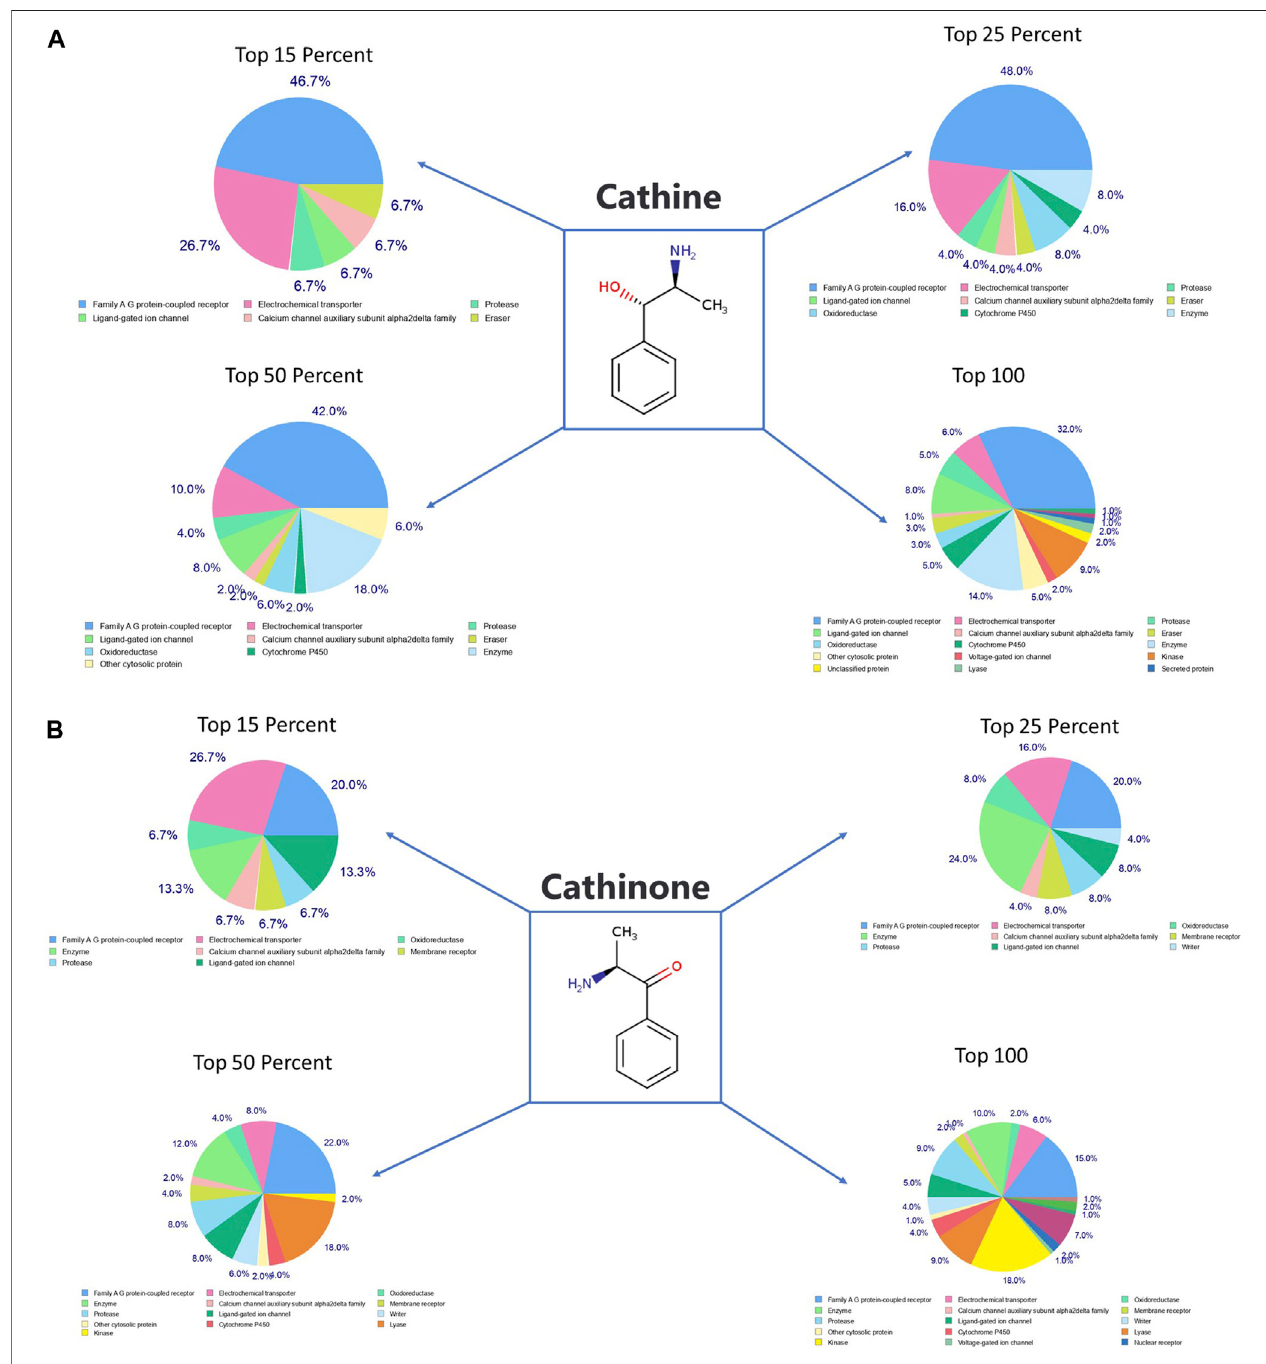
FIGURE 7 | SwissTargetPrediction analysis for cathine (A) (PubChem CID 441457) and cathinone (B) (PubChem CID 62258) showing top targets for both components. Cathine and cathinone have the highest percentage of binding (32 and 15%, respectively) with family A G-protein-coupled receptors.